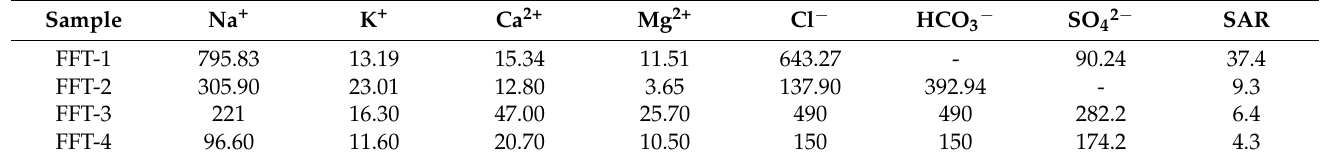
Table 3. Major cations and anions. Unit is mg/L.